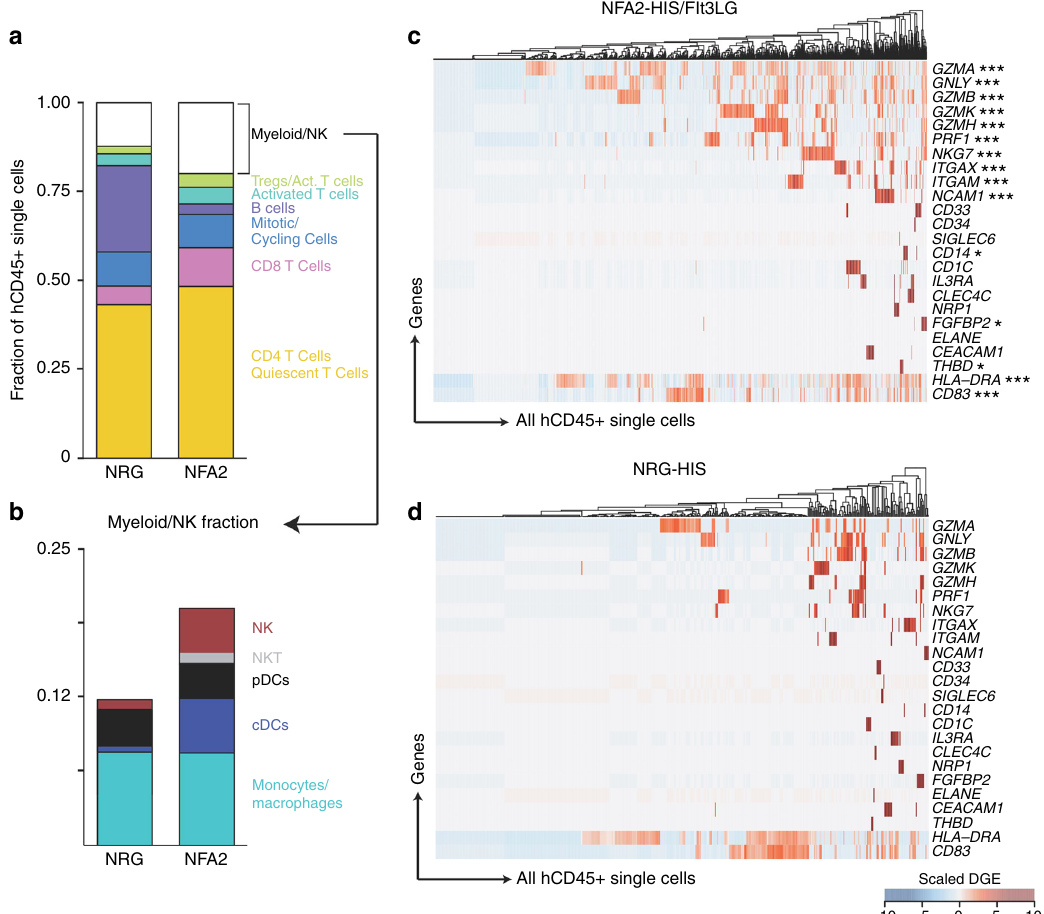
Fig. 9 ScRNA-Seq-based measurement of the myeloid and NK cell engraftment. a , b Chart bart displaying the fraction of human cell subsets within the hCD45 + compartment in both NRG-HIS and NFA2-HIS/Flt3LG mouse spleens ( a ). The fraction of multiple myeloid and NK subsets is highlighted within a second chart bart ( b ). Cell subsets are colored as in Fig. 8a, c. c , d Heatmap of all hCD45 + single cells in NFA2-HIS/Flt3LG ( c ) and NRG-HIS ( d ) mice over myeloid, DC, NK, and granulocyte subpopulation-de fi ning genes. Differentially expressed genes between NRG-HIS and NFA2-HIS/Flt3LG mice are shown in ( c ) (* p ≤ 0.05, ** p ≤ 0.01, *** p ≤ 0.001; Benjamini – Hochberg adjusted p -values). Tregs regulatory T cells, NK natural killer cells, NKT natural killer T